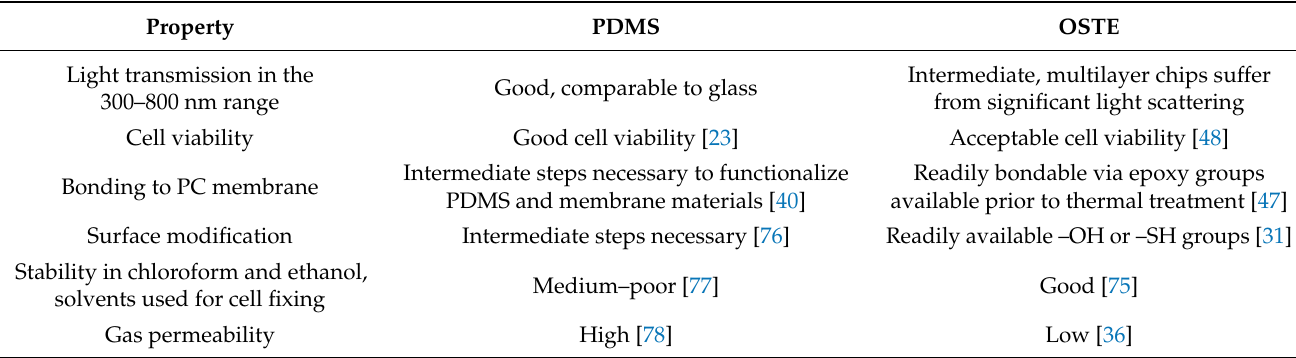
Table 1. A comparison between polydimethylsiloxane (PDMS) and off-stoichiometry thiol–ene (OSTE)